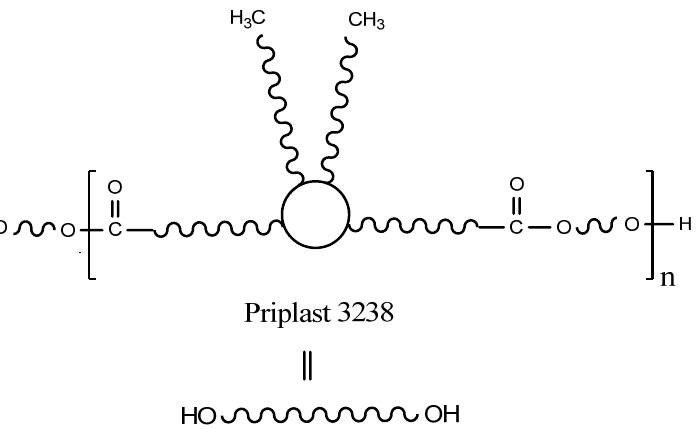
Figure 2. The chemical structure of Priplast 3238. The additives to formulate the printing pastes were supplied by Color Center, S.A. (Terrassa, Spain) and are: Defoamer PR (defoamer, mineral oil-based), Complex DG (di- ethylene glycol-based, runnability improver), DMEA (dimethylethanolamine, neutralizing agent), and Thickener L-120 (polyacrylic acid, associative thickener). Pristine polyester fabric (UPRON) was supplied by HEDVA a.s. (Moravsk á Tˇrebov á , Czech Republic) and was used as a substrate to perform the coatings. The main character- istics of the pristine UPRON fabric are summarized as follows: 100% polyester fabric (PET, polyethylene terephthalate), plain weave, 172 ± 5 g m − 2 ; threads per cm: warp 32 ± 2, weft 14 ±